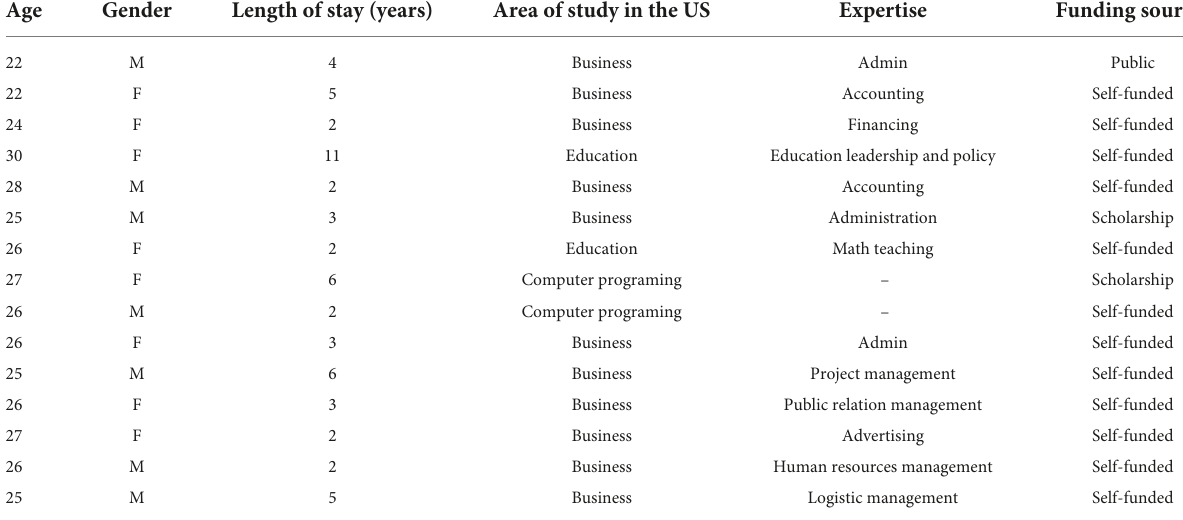
TABLE 1 Participants’